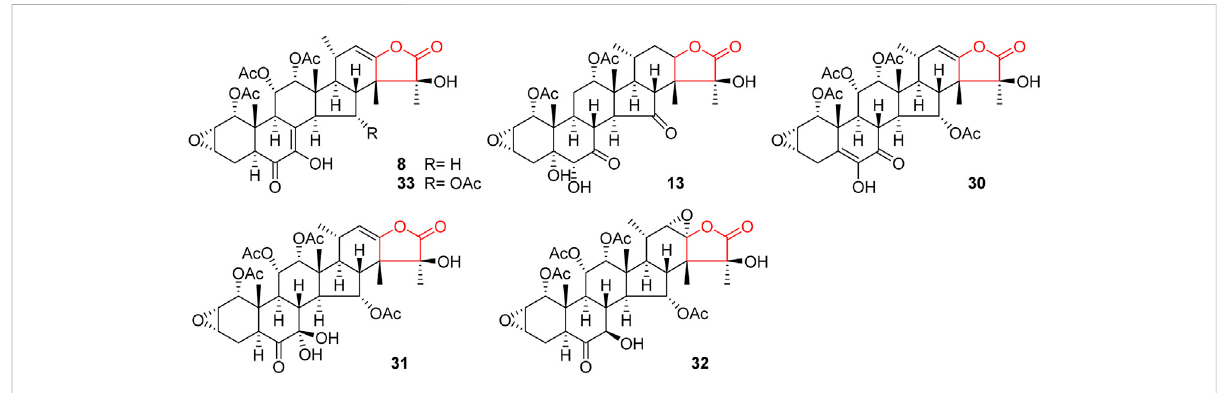
FIGURE 2 Structures of taccalonolides with lactone ring at C23 – C26.